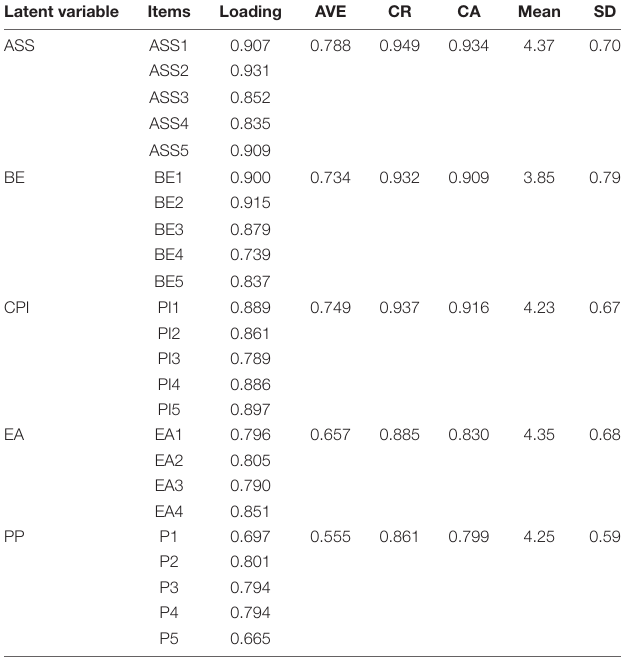
TABLE 2 | Results of measurement model